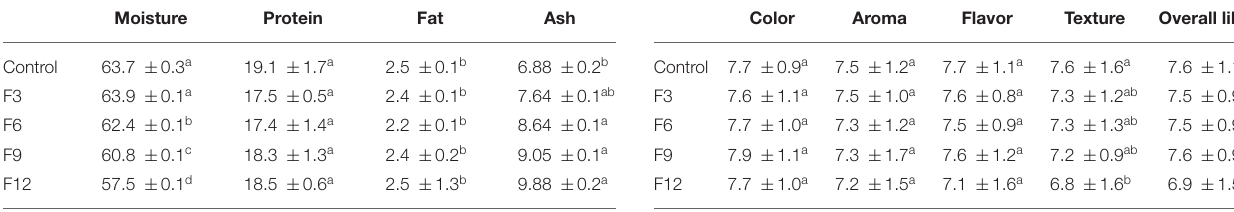
TABLE 5 | Consumer’s acceptance of prebiotic burgers. Color Aroma Flavor Texture